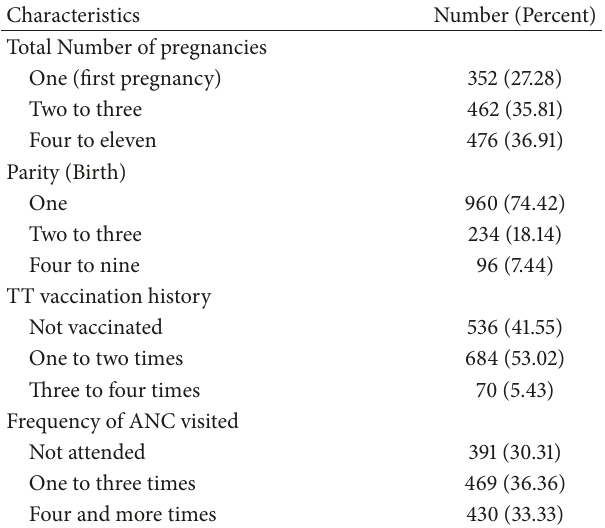
Table 2: Obstetric characteristics of pregnant mothers at DHDSS site, northwest Ethiopia,